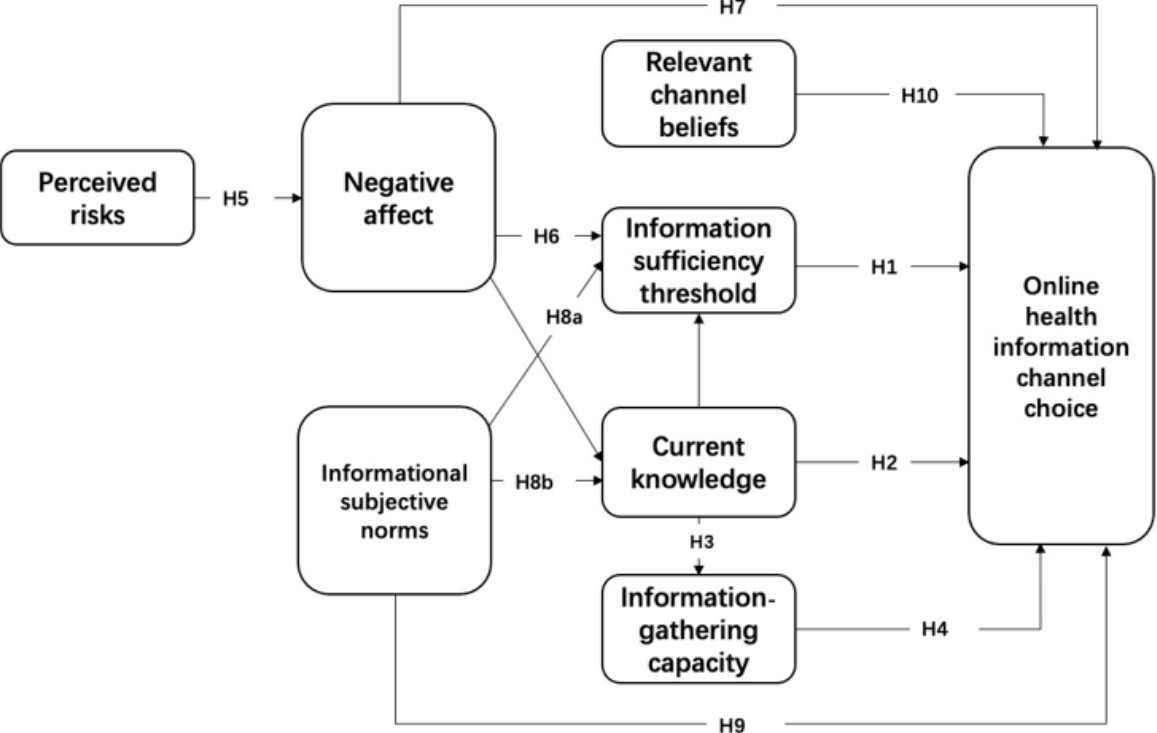
Figure 1. Conceptual model. The lines between current knowledge and negative affect and information sufficiency threshold were added for the purpose of statistical control. Thus, these lines are unmarked. H: